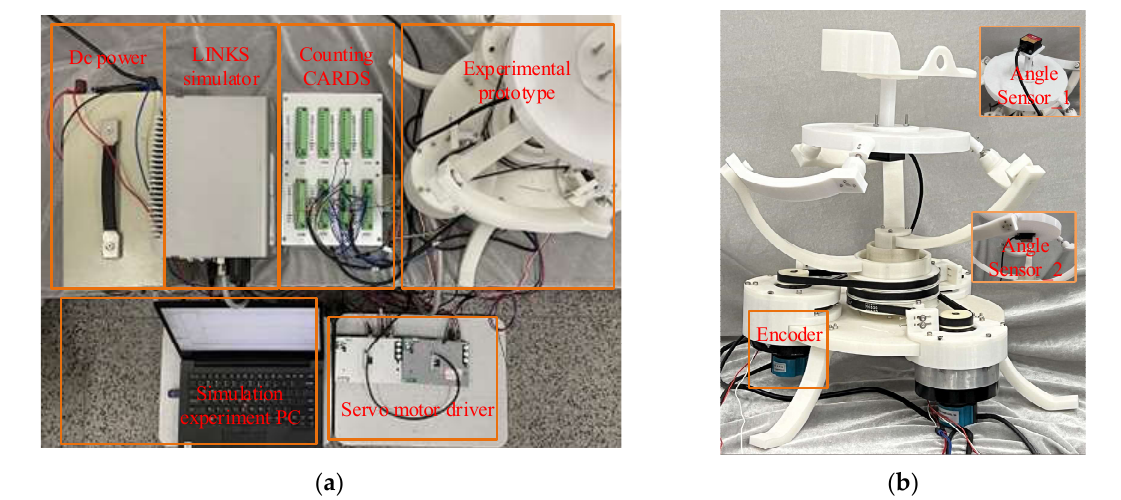
Figure 12. ( a ) The experimental device. ( b ) The error curve of the trajectory.